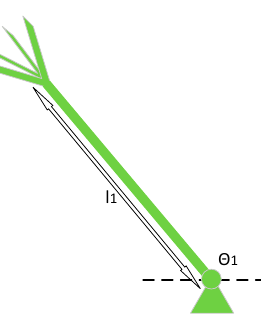
Figure 10. One linkage mechanism.